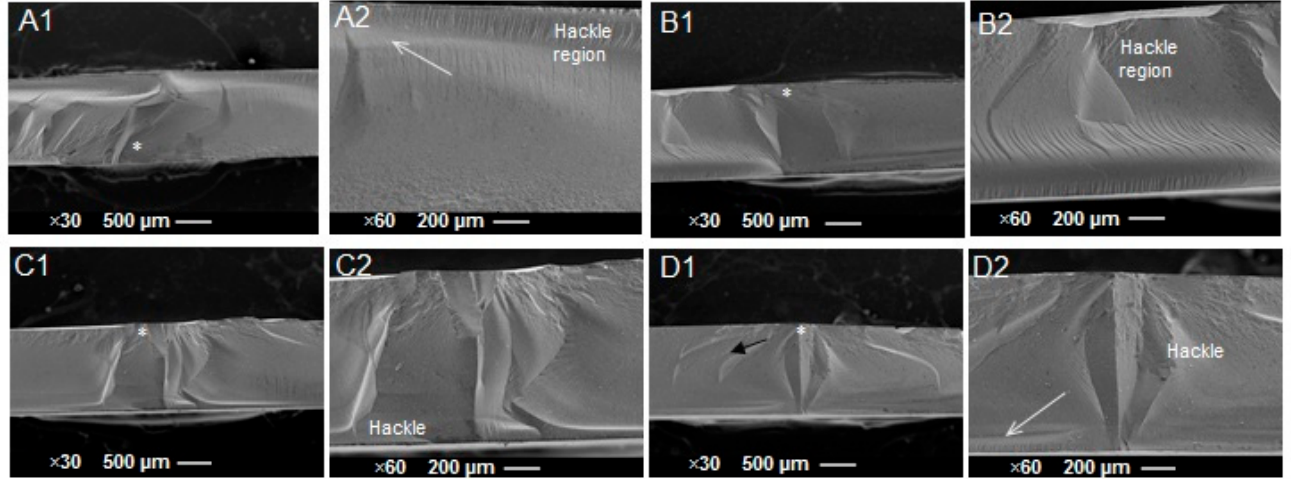
Figure 6. SEM images of fractured surface of representative CS specimen following BFS test: ( A1 ) control specimen shows the fracture origin (asterisk). Multiple crack planes and voids are also shown; ( A2 ) higher magnification shows compression curl (solid white line) and hackle region; ( B1 , B2 ) MP specimen displaying fracture features similar to the control group; ( C1 ) OG specimen shows the crack origin; ( C2 ) higher magnification shows multiple fracture planes, larger voids, and more distinctive hackle regions propagating from the voids; ( D1 ) MP+PP specimen shows the crack origin and crack arrest lines (solid black line); ( D2 ) multiple crack planes, compression curl, and hackle region are shown.